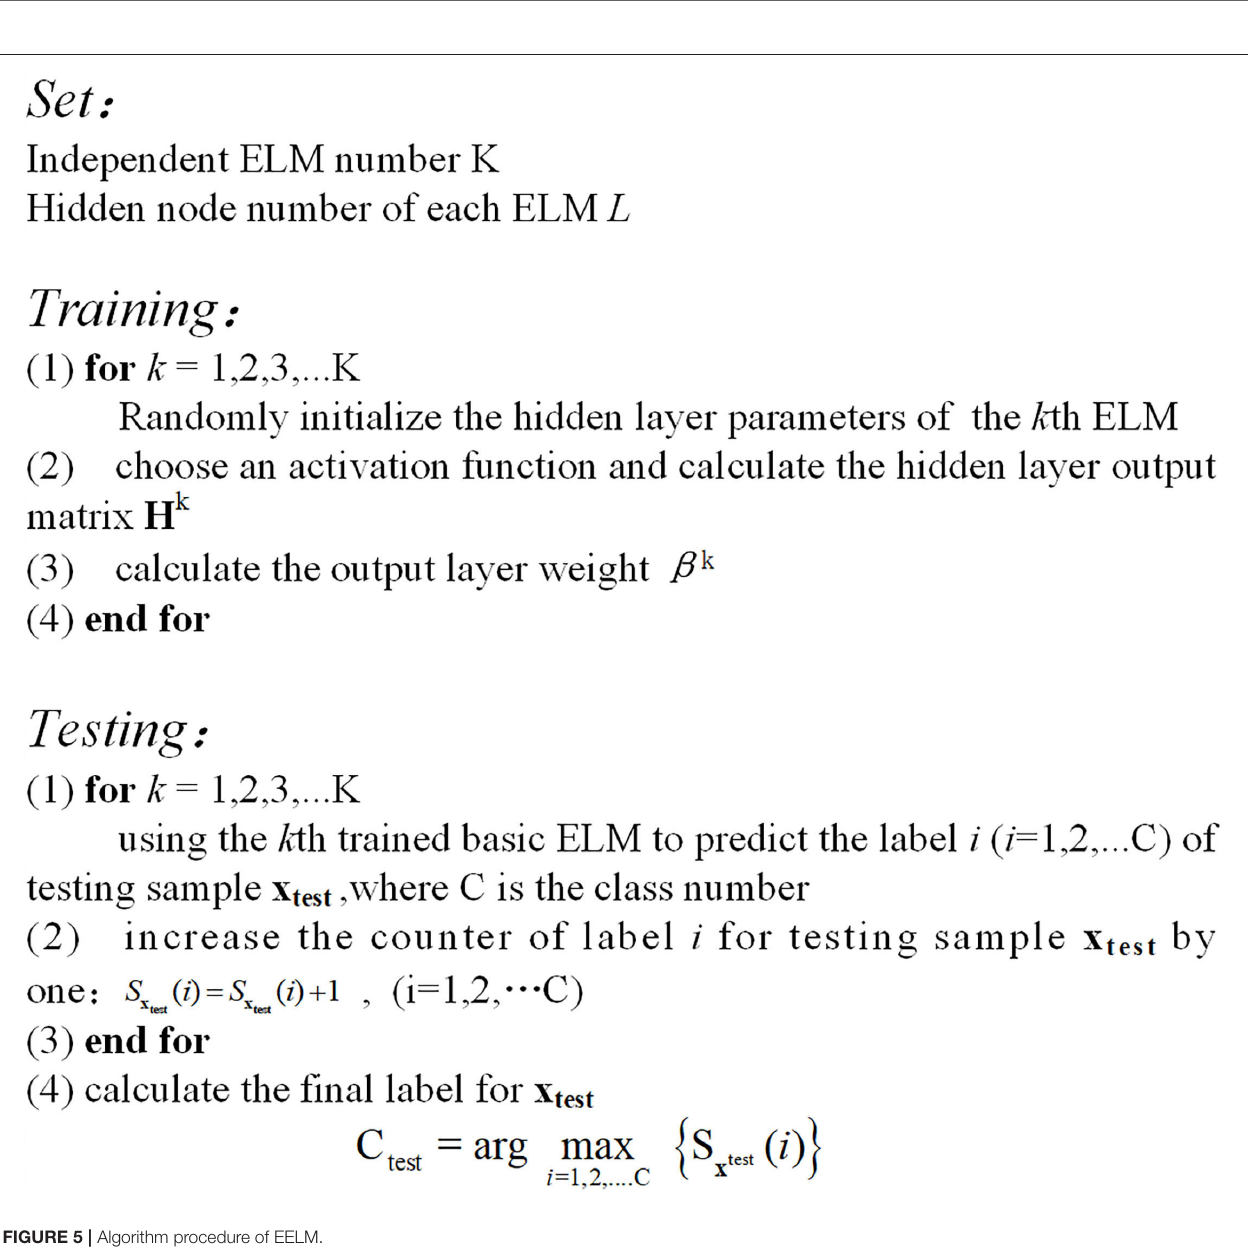
FIGURE 5 | Algorithm procedure of